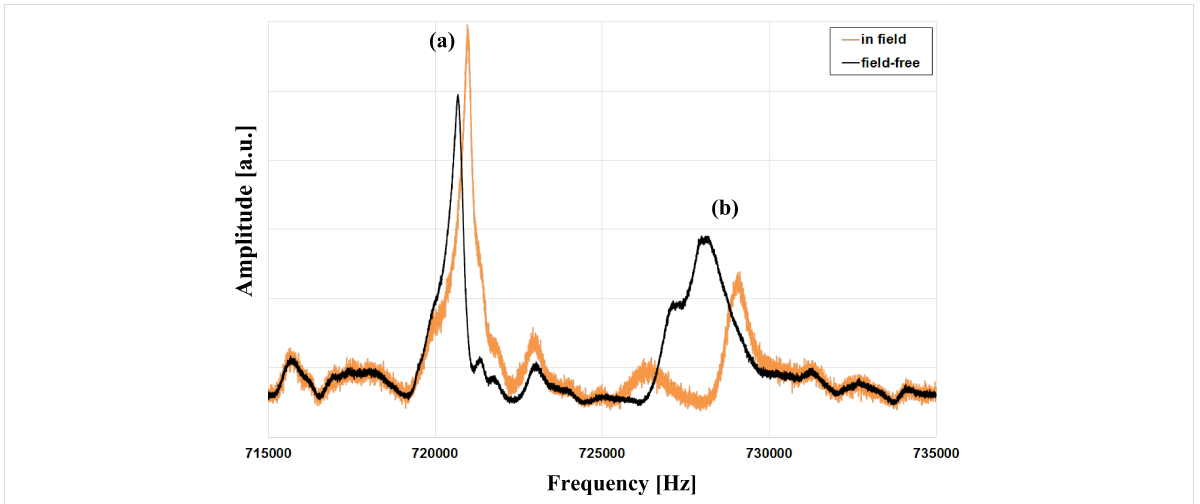
Figure 6: Amplitude response curves of the cantilever measured at the field-free position (3) according to Figure 4 and approximately 100 μ m above the surface of the magnet (position (2)). The peaks are marked with (a) and (b) for reference purposes.